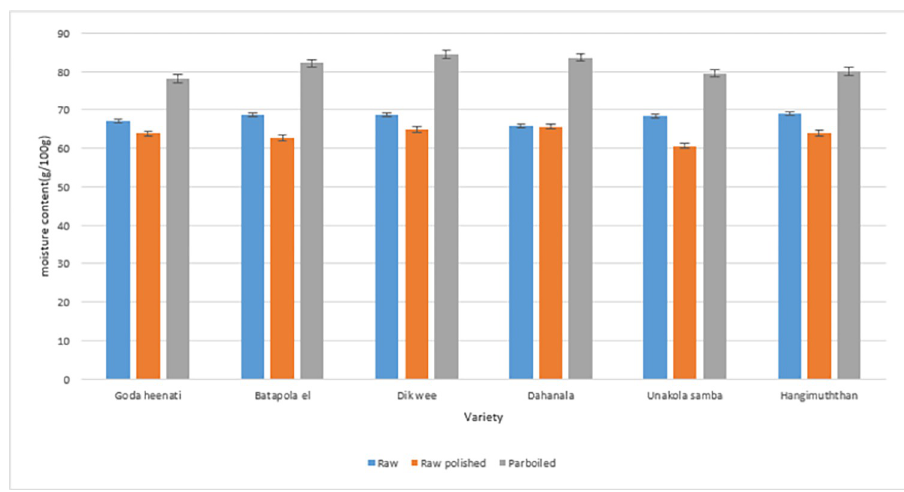
Fig 1. Moisture contents of differently processed freshly cooked rice (mean ±